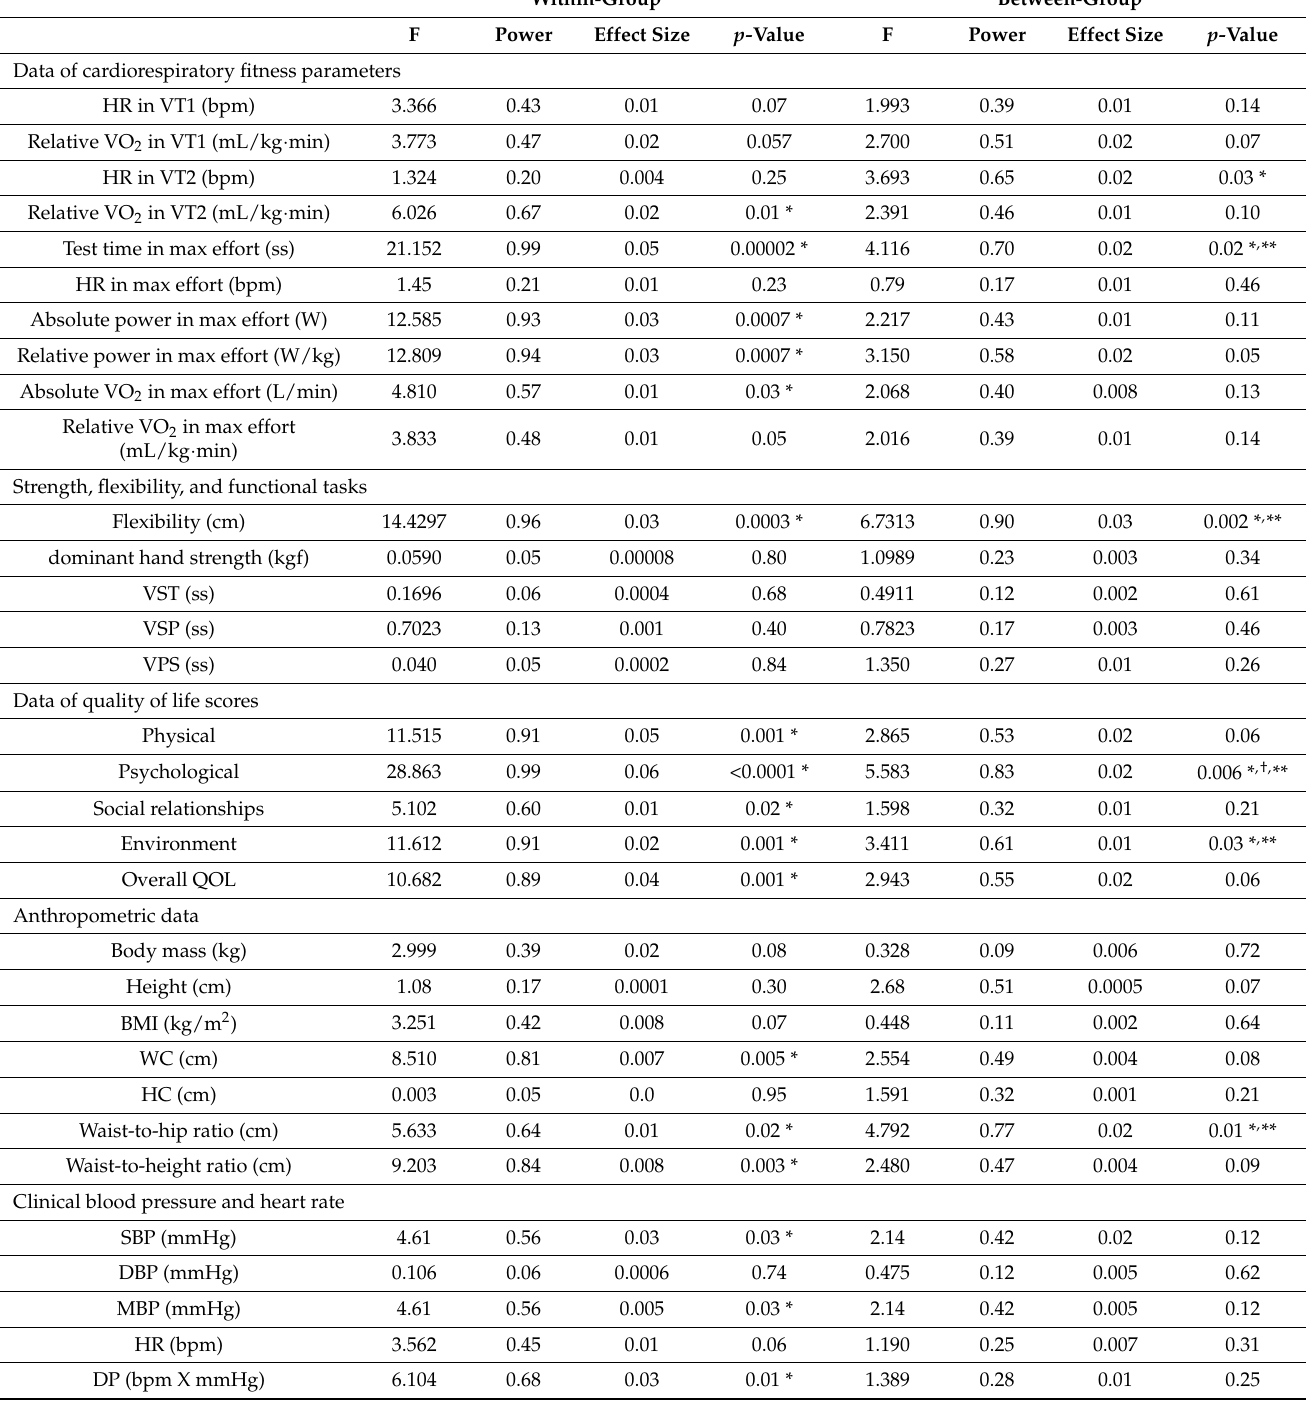
Table 4. Between-group and within-group comparisons for the outcomes. Within-Group Between-Group F Power Effect Size p- Value F Power Effect Size p-